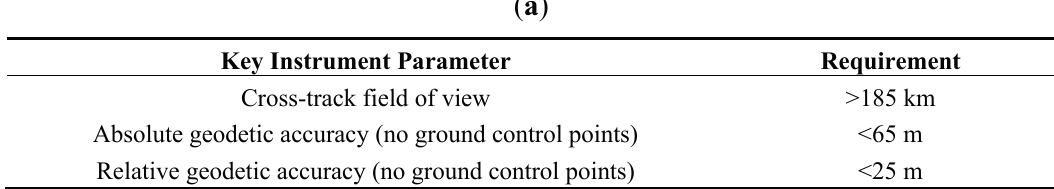
Table 1. Key instrument parameters ( a ); selected top level requirements ( b ). The individual bands and their spectral (center wavelength (CW) and bandwidth), spatial (ground sample distance (GSD)) and signal-to-noise (SNR)